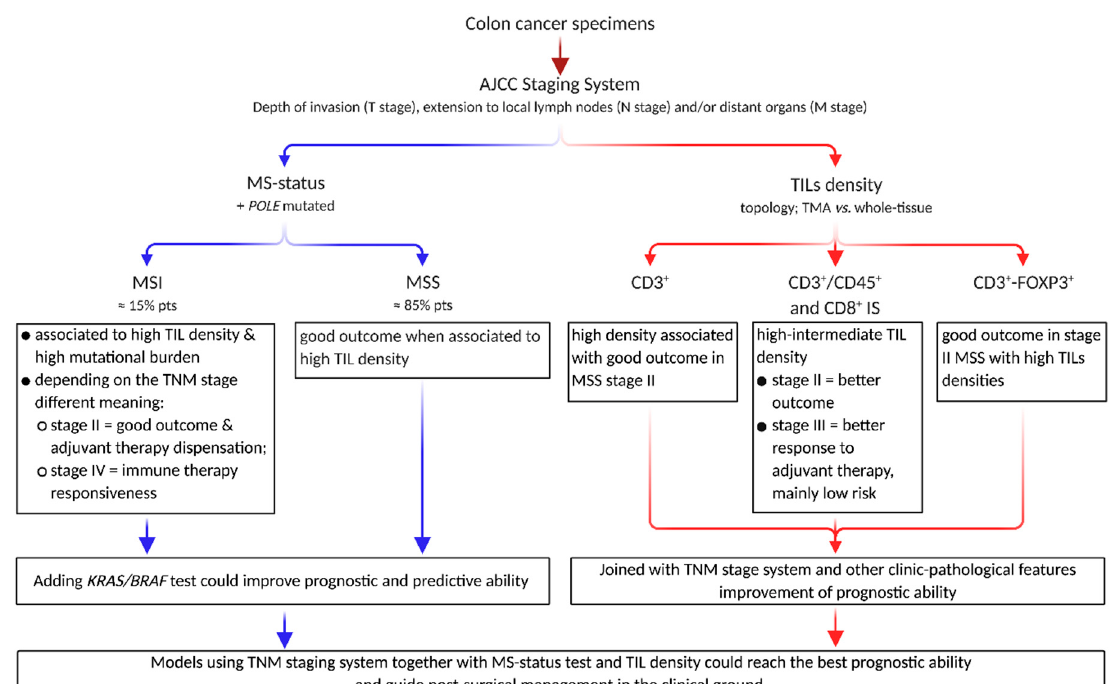
Figure 1. The prognostic and predictive ability of pathological and biological colon cancer features interact to impact post-surgical outcome. In addition to the pathological AJCC cancer staging system, the post-surgical medical decisions are implemented by the MS-status assessment, plus mutation in the RAS family and POLE gene. TILs progressively became relevant players in forecasting patient outcome in di ff erent clinical settings, possibly including the responsiveness adjuvant treatment. Abbreviations: AJCC, American Joint Committee on Cancer; IS, Immunoscore; MS-status, microsatellite status; MSI, microsatellite instability; MSS, microsatellite stability; TIL, tumor-infiltrating lymphocyte; TMA, tissue